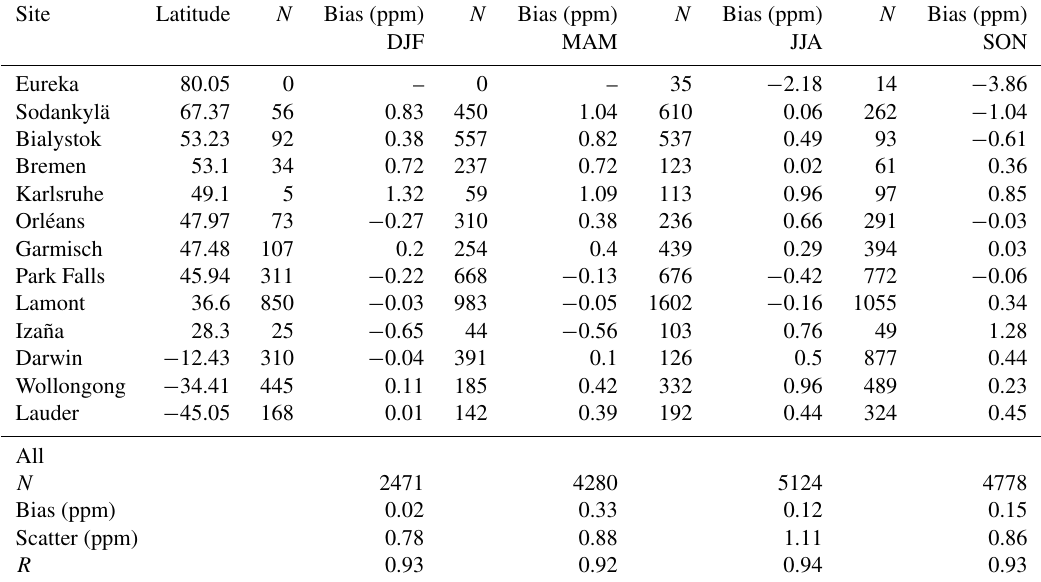
Table 3. Seasonal bias (ppm) for the hourly averaged X CO comparison between TCCON measurements and GEM-MACH-GHG simula- 2 tions. The mean (using data from all sites) bias (ppm), scatter (ppm) and correlation coefficient ( R ) are also shown under “all”. Seasons with fewer than 10 pairs are not included in the “all”